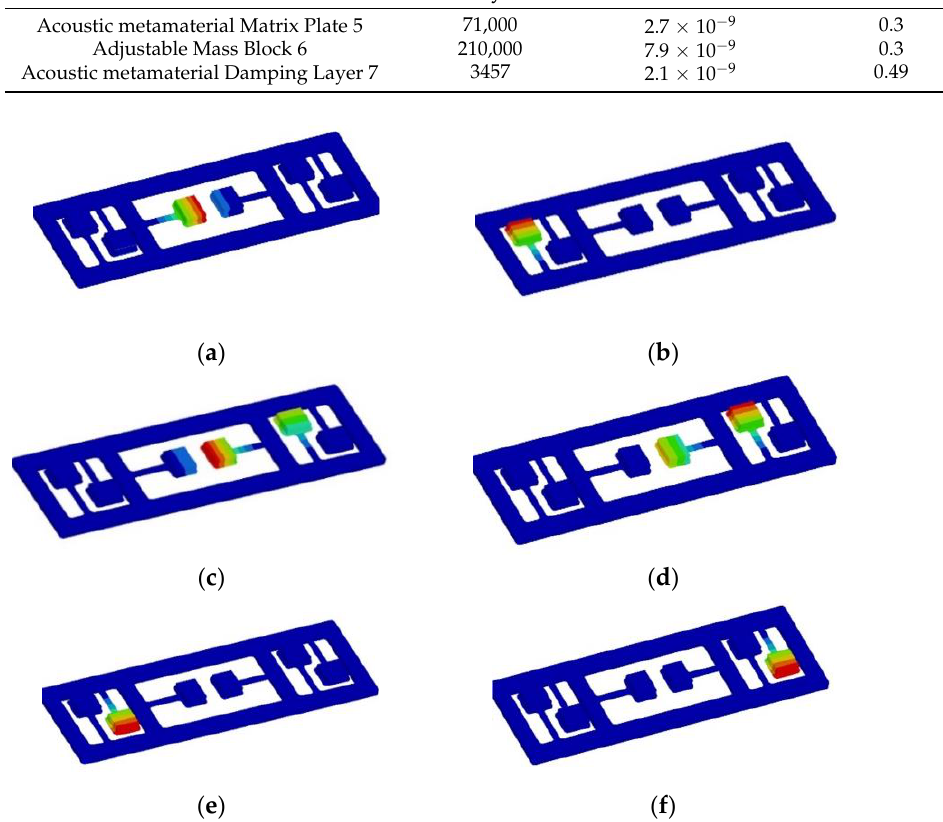
Figure 17. Natural frequency of acoustic metamaterial resonance element. ( a ) 34.94 Hz, ( b ) 34.94 Hz, ( c ) 34.95 Hz, ( d ) 34.95 Hz, ( e ) 35.00 Hz, ( f ) 35.00 Hz.